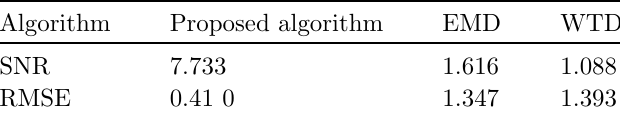
Table 3. Performance comparison of different methods.